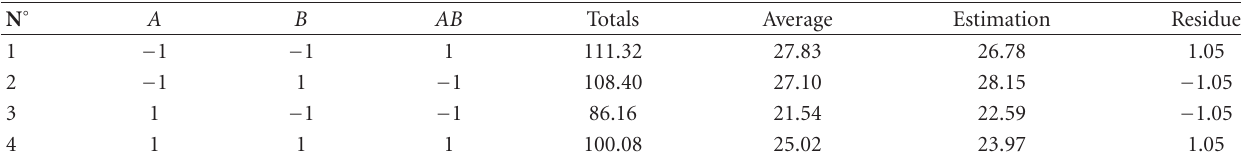
Table 7: Experiment plan (2 2 )-data.